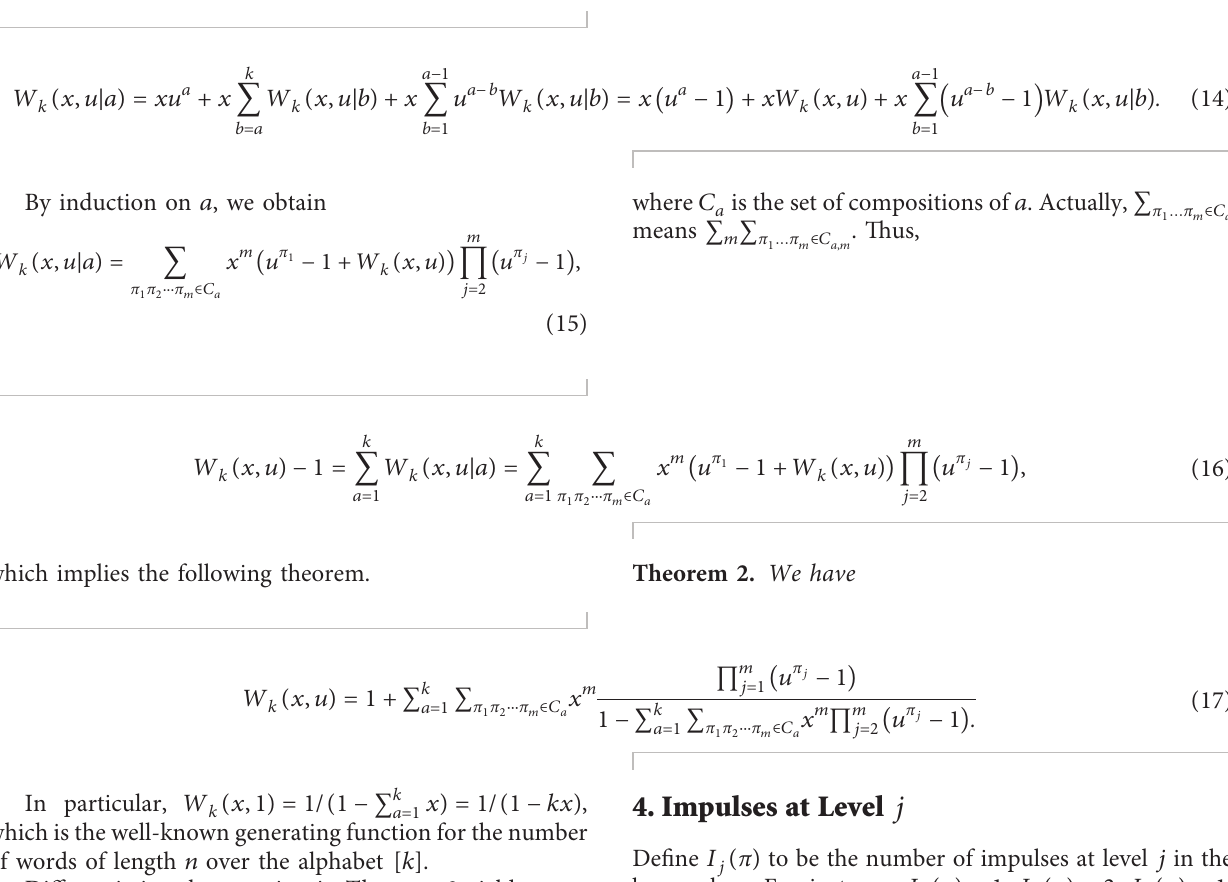
Figure 1. Define H ( x, y ; q function for the number of compositions of n with exactly